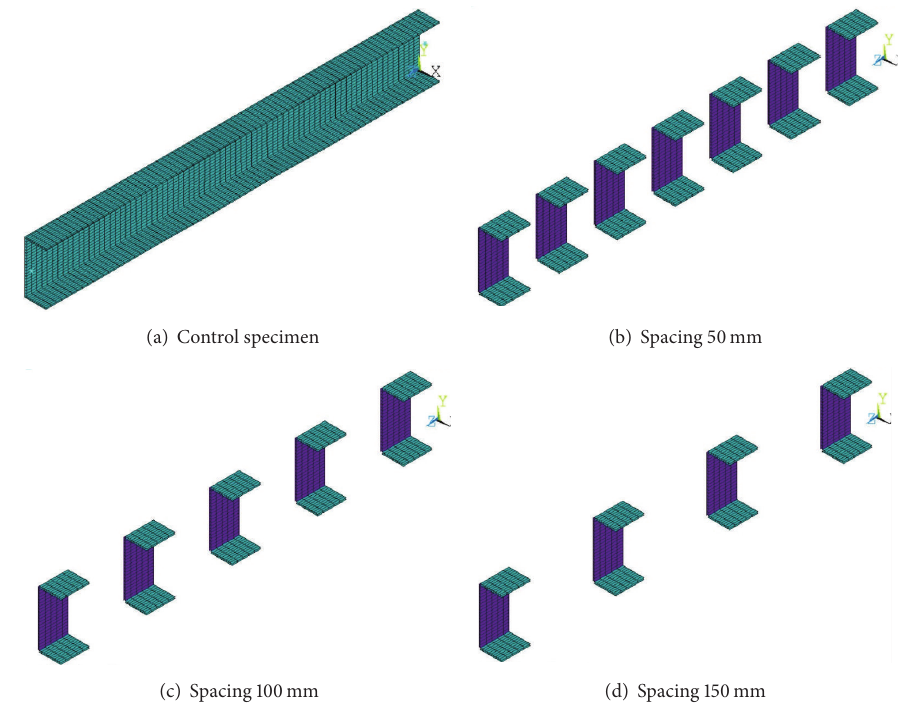
Figure 9: Finite element